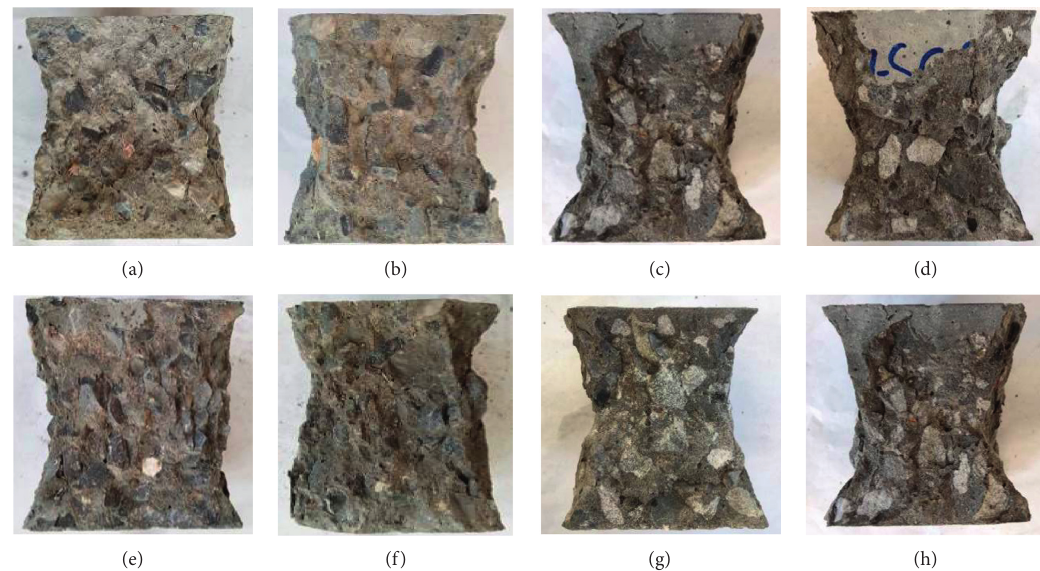
Figure 7: Concrete failure section. (a) NAC-C30. (b) N-SFC-C30. (c) N-SAC-C30. (d) N-SC-C30. (e) NAC-C40. (f) N-SFC-C40. (g) N- SAC-C40. (h)